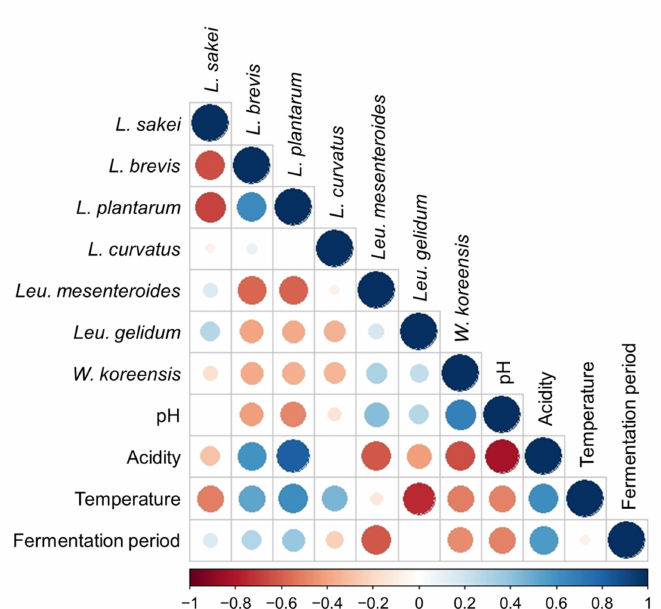
Figure 4. Pearson correlations calculated for the environmental factors (pH, acidity, fermentation temperature, and fermentation period) and relative abundance of major lactic acid bacterial species. The blue and red colors correspond to positive and negative correlations, respectively. The circle size and color intensity are proportional to the correlation